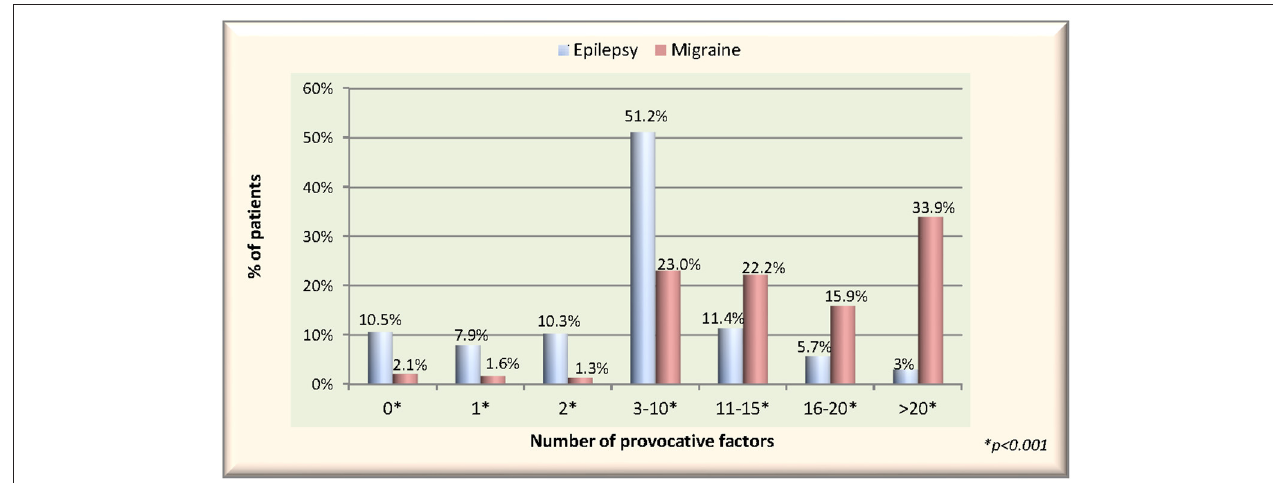
FIGURE 3 | The rates of reported number of provocative factors per patient in migraine vs. epilepsy groups.